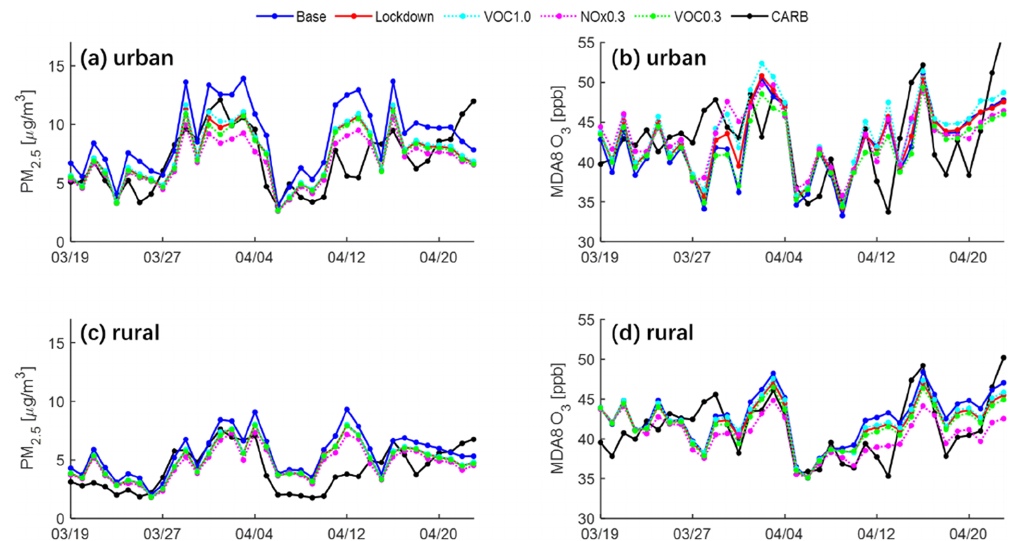
Figure 10. Time series of simulated and observed PM 2 . 5 concentrations (a, c) and MDA8 O 3 concentrations (b, d) under several sensitivity scenarios averaged across the CARB observational stations over the urban (a, b) and rural (c, d) areas of southern California during the lockdown period (19 March to 23 April). Black lines are surface observations from CARB networks. Blue, red, cyan, magenta, and green lines are simulated results for the Base, Lockdown, VOC1.0, NO x 0.3, and VOC0.3 scenarios. The definitions of all scenarios are summarized in Table